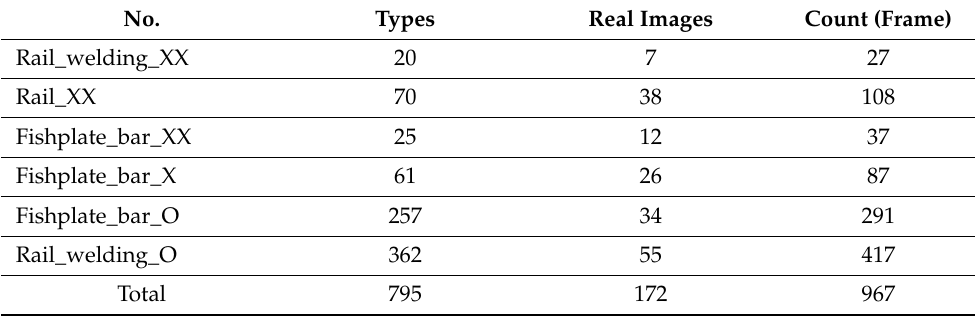
Table 5. The original side ‐ view dataset.